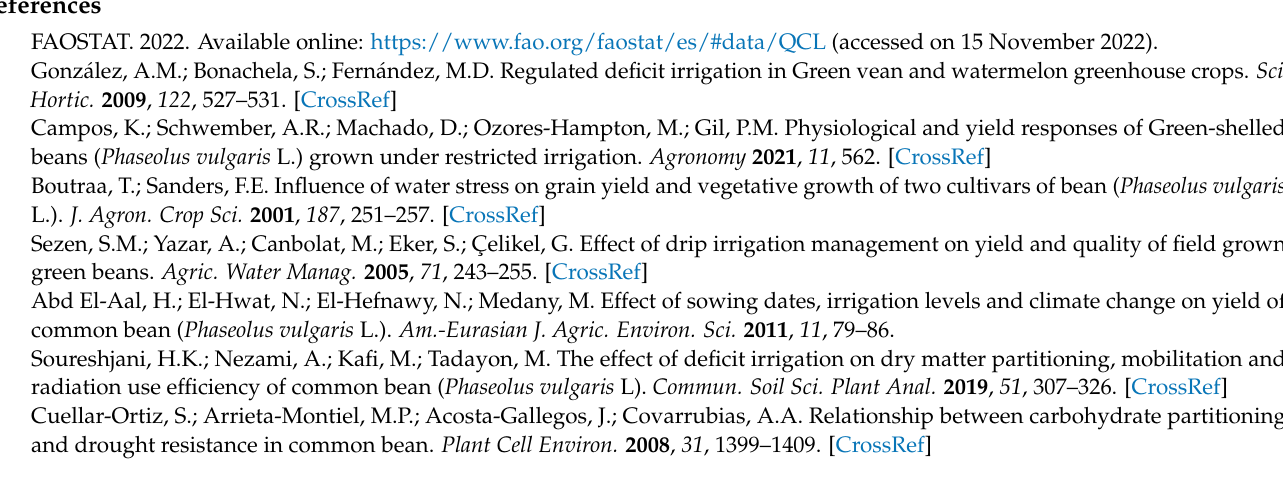
Figure A1. Harvested pod of cv Helda ( a ) and cv P Blanca ( b ). In both pictures, pods on the right of the ruler were considered non-commercial (hooked